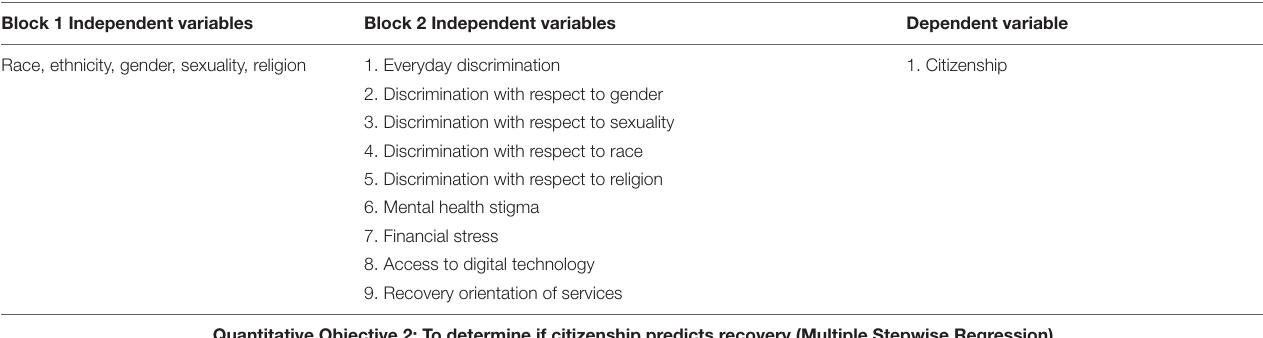
TABLE 2 | Quantitative analyses 1. Quantitative Objective 1: To examine predictors of citizenship (Multiple Stepwise Regression) Block 1 Independent variables Block 2 Independent variables Dependent variable Race, ethnicity, gender, sexuality,